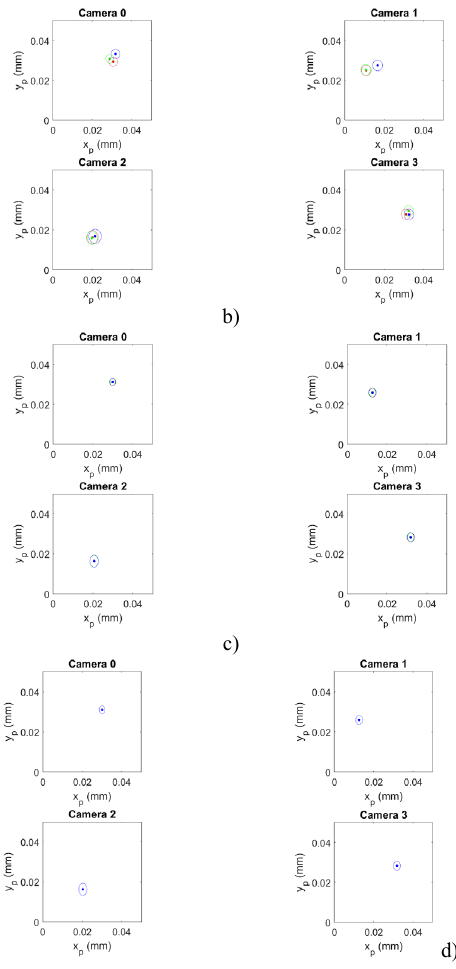
Figure 7. Go Pro Hero 5 principal point and 95% confidence region for a) Case 1, b) Case 2, c) Case 3, d) Case 4.